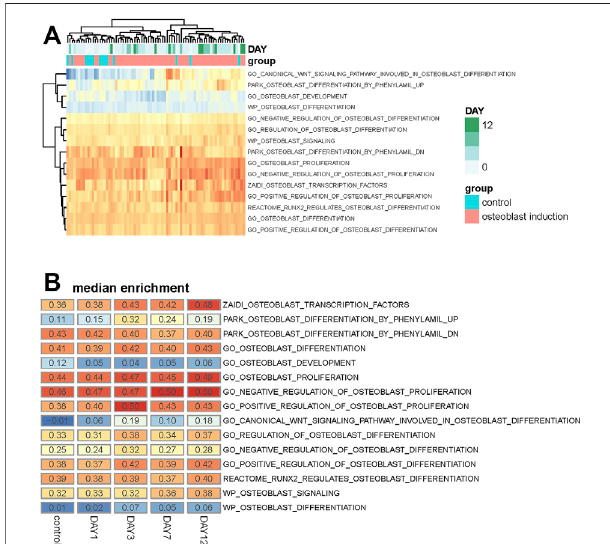
FIGURE 2 | Analysis of osteoblast-related pathways in the osteogenic process. (A) Heat map shows the enrichment score of 15 osteoblast-related pathways across all samples. Samples are annotated into different groups anddays. (B) Heatmapshowsthemedianvalueoftheenrichmentscore of these osteoblast-related pathways across different osteogenic stages.